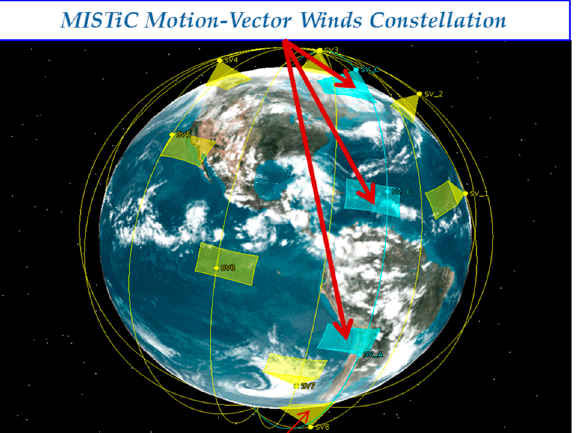
Figure 1. Hyperspectral motion vector winds and infrared (IR) sounding constellations employing low earth orbit sun-synchronous orbit (LEO SSO) constellations. A winds constellation (blue) of three microsatellites in each of two orbital planes provides vertically resolved tropospheric winds and IR soundings globally, every six hours.